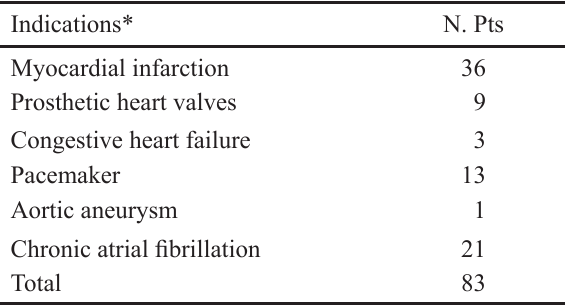
Table 1 – Indications for oral anticoagulant